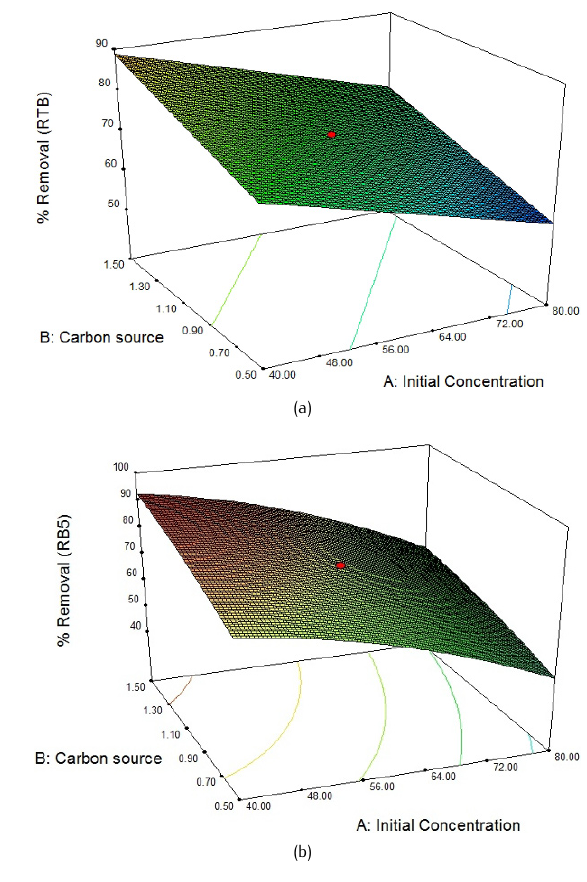
Figure 3. Biodecolourization of dyes on 3-D graphics for response surface optimization Initial dye concentration versus Car- bon source (a) RTB and (b)